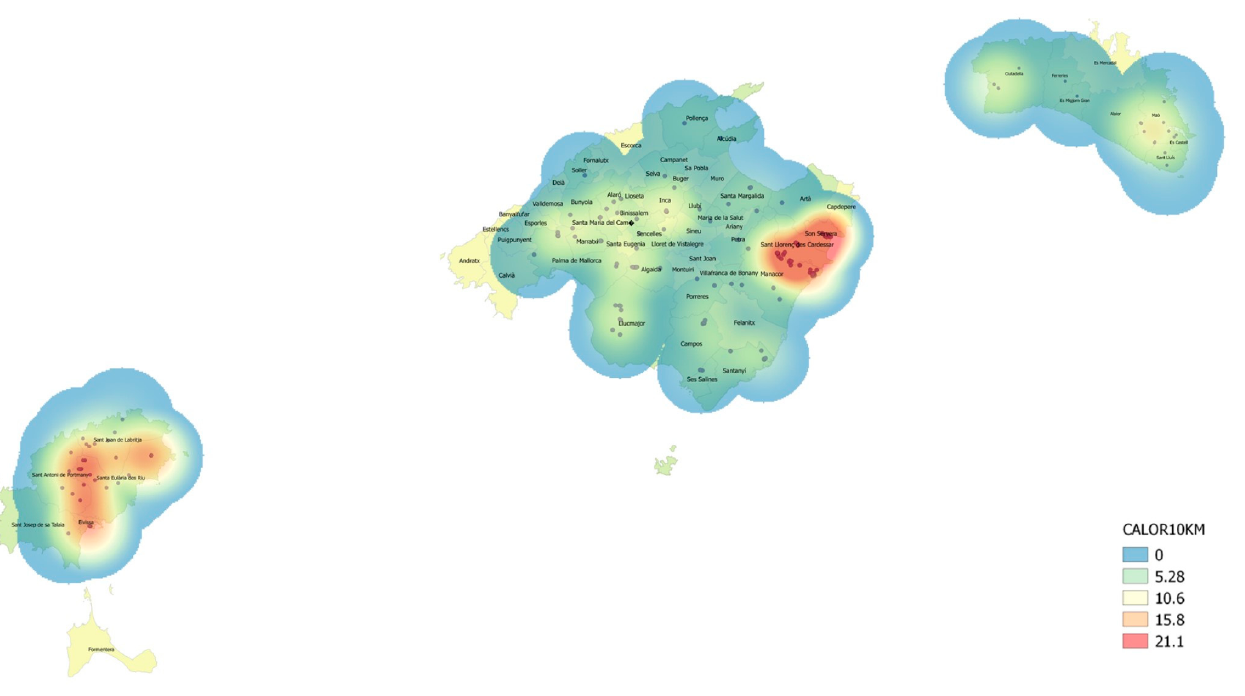
Figure 1. Density map of the number of Xf-qPCR+ samples per Km at the first Audit DG SANTE in June 2017. Demarcated 10 Km areas in blue